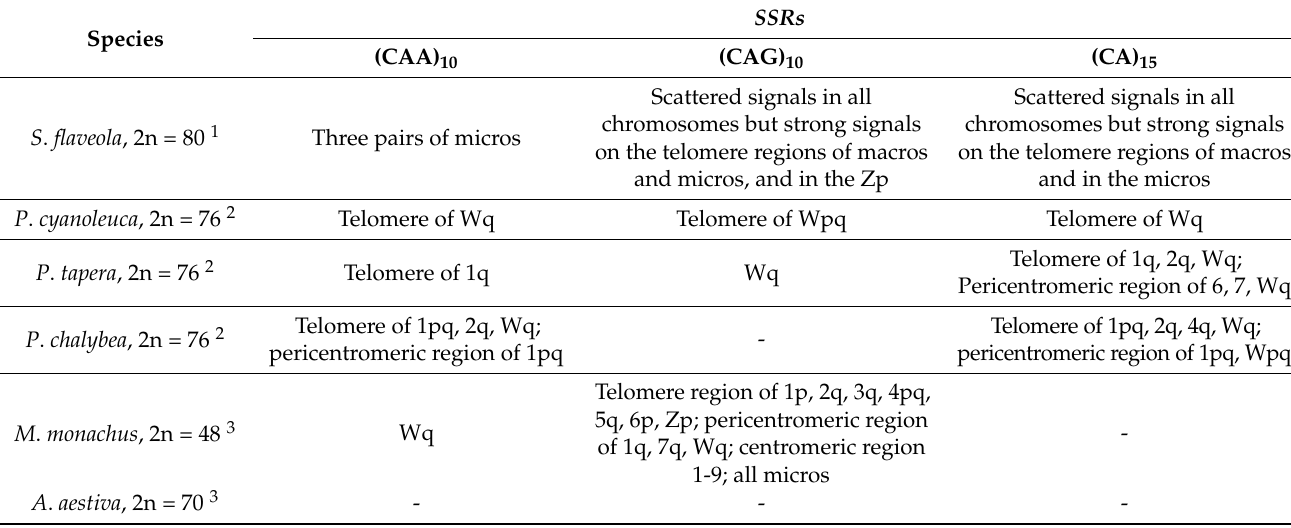
Table 1. Chromosome mapping comparison of microsatellites among Passeriformes and Psittaciformes species.